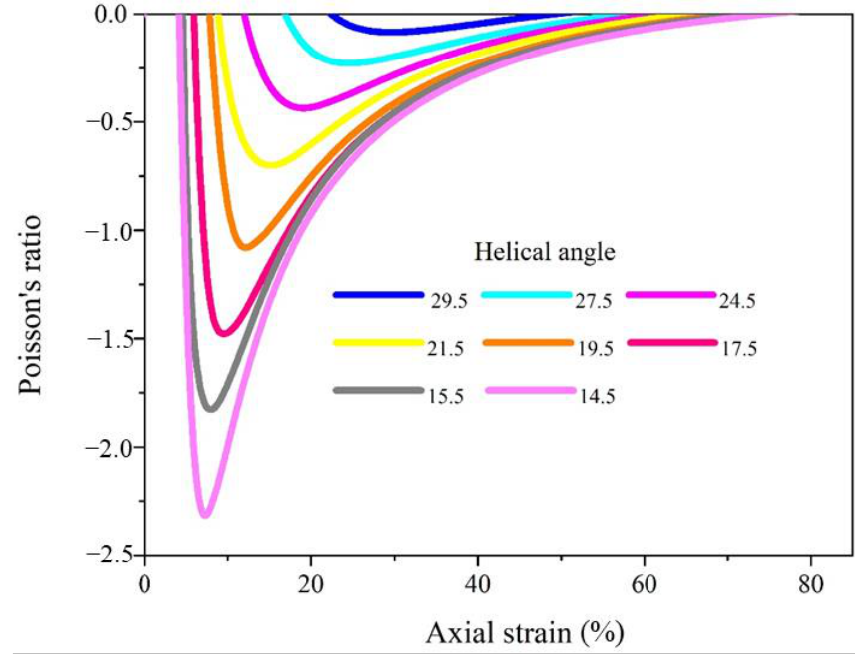
Figure 4. The effect of helical angle on the auxetic property of auxetic yarns.